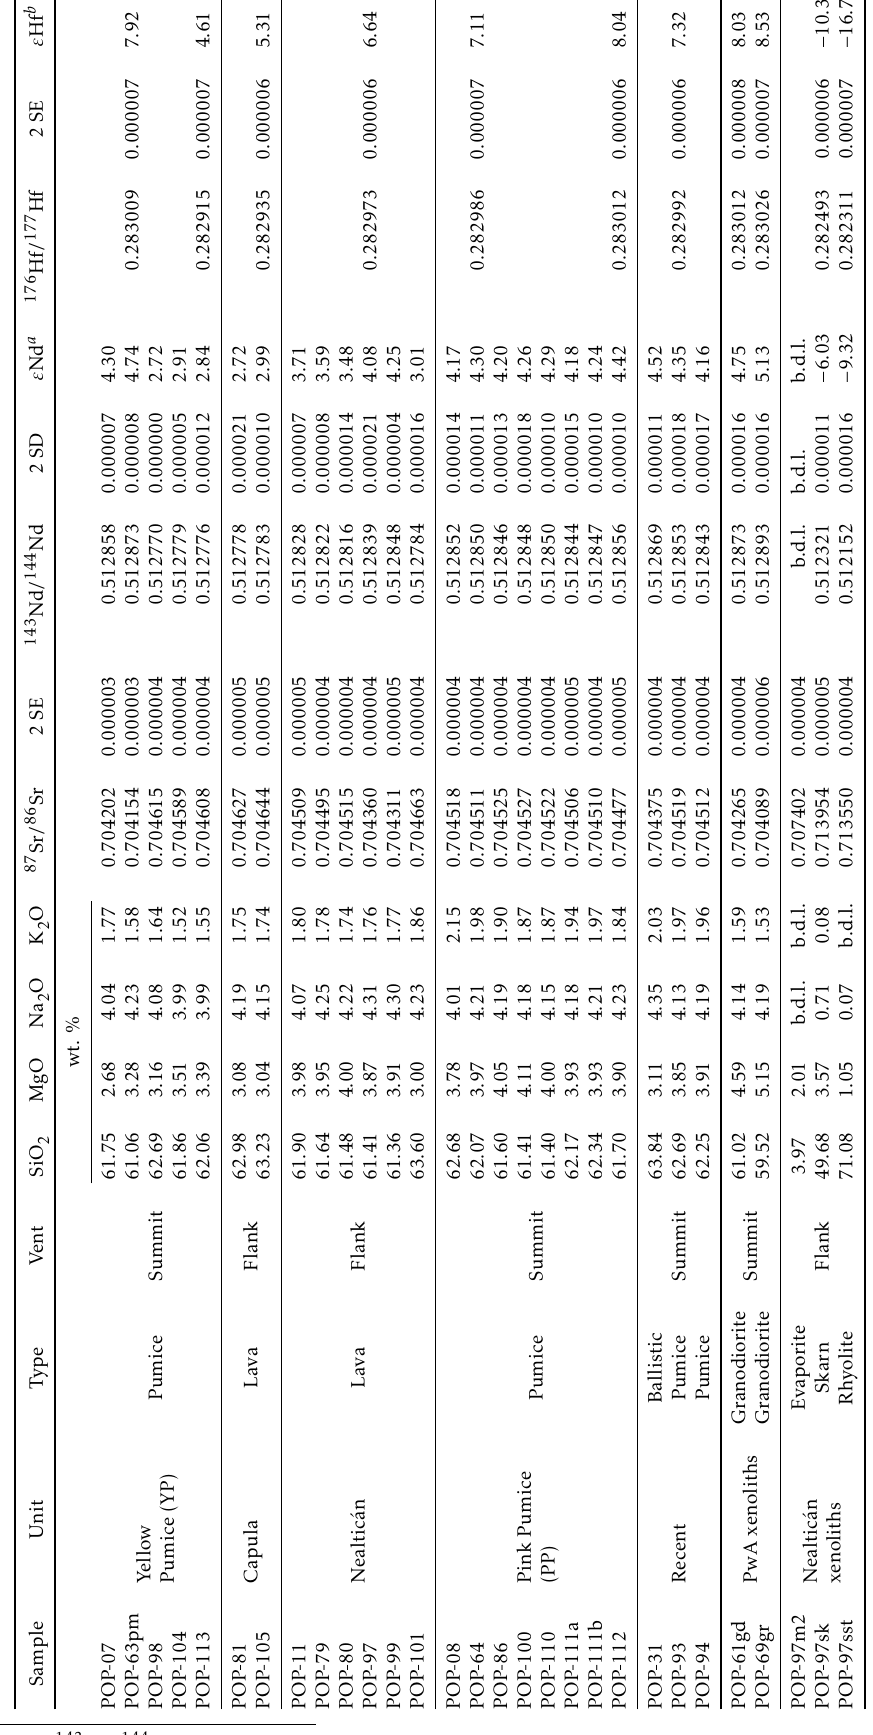
Table 1: [cont.] – Sr–Nd–Hf isotopic composition of Popocatépetl and Ventorrillo